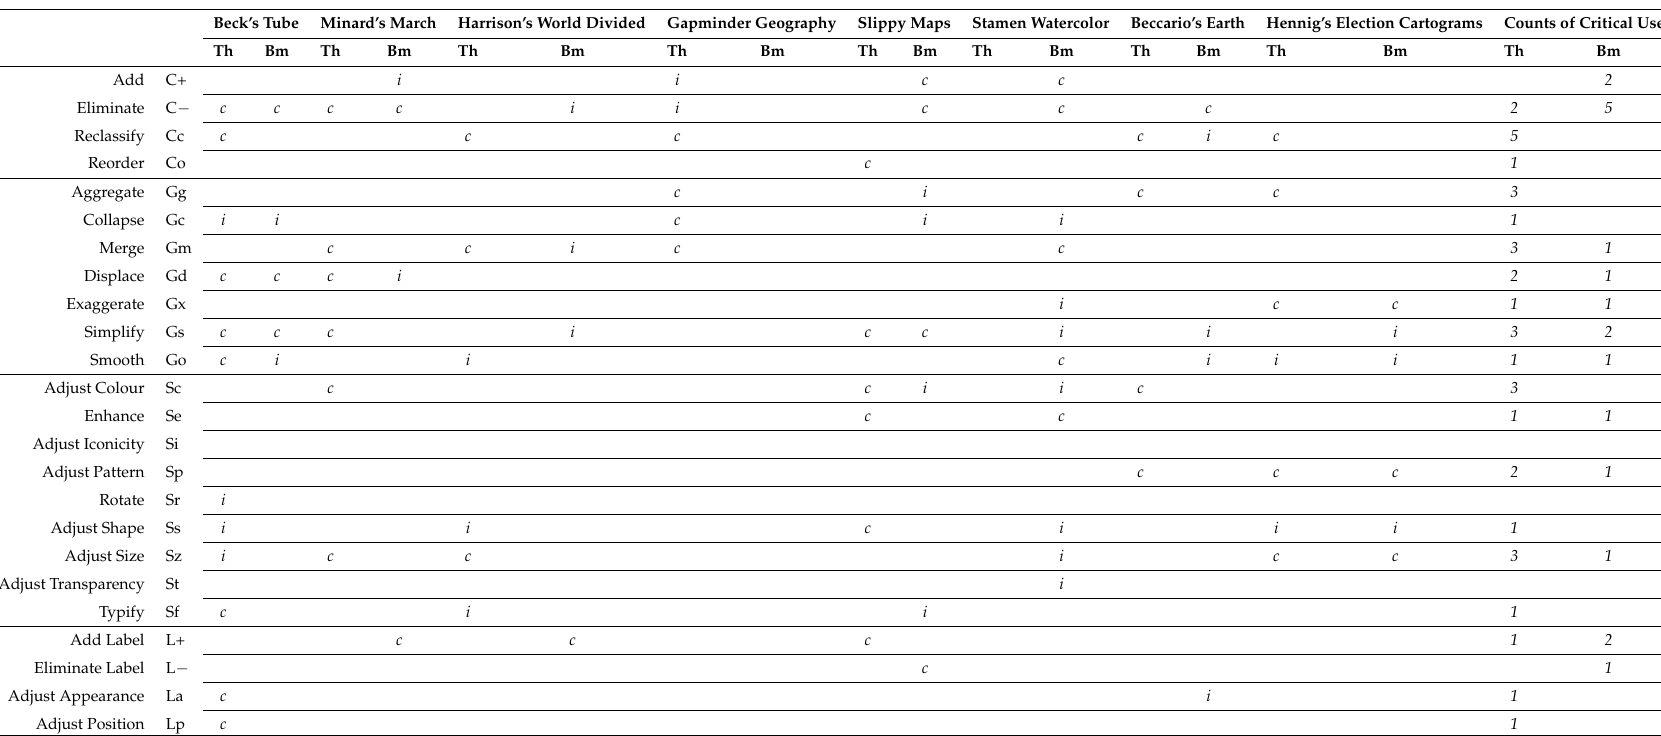
Table 10. A summary of operators used among thematic (Th) and basemap (Bm) layers in all map examples presented, classified as either critical to the definition of the thematic message of the map ( c ), or incidental to it ( i ). Tallies of critical uses across these examples are also